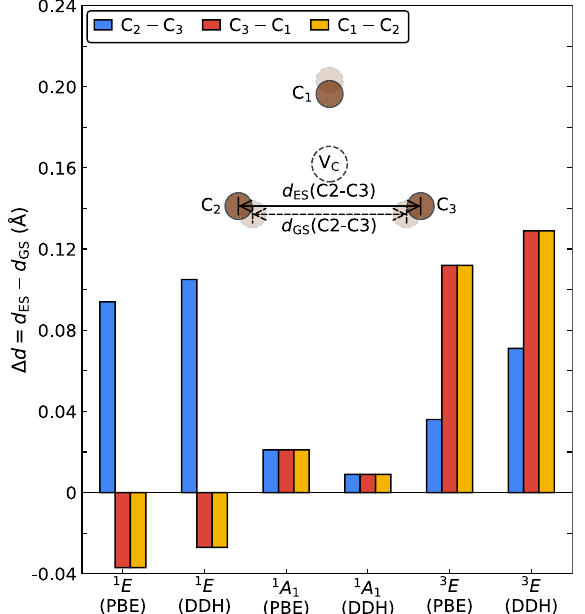
Fig. 3 Geometrical con fi gurations of many-body states of the NV − center in diamond. Differences of the distances between the three carbon atoms (C 1 , C 2 and C 3 ) around the vacancy site (V C ), as obtained in the excited states (ES) and ground state (GS): − d Δ d = d 1 E , 1 A 3 E ES GS . The differences are reported for the 1 and ESs and are computed using TDDFT with PBE or DDH functionals. Note that Δ d (C 1 − C 2 ), Δ d (C 2 − C 3 ) and Δ d (C 3 − C 1 ) for the 3 E state differ, due to the coupling of the electronic state to both a 1 and e type phonon modes (see text). For the 1 A 1 state, Δ d (C 1 − C 2 ), − C Δ d (C − C Å , Δ d (C 2 3 ) and 3 1 ) are instead all equal to ~0.02 implying that in this case the equilibrium geometry preserves the C 3v symmetry and is close to that of the 3 A 2 ground state. The differences Δ d (C 1 − C 2 ), Δ d (C 2 − C 3 ) and Δ d (C 3 − C 1 ) of the 1 E state differ, due to a signi fi cant coupling with e type phonon modes, leading to symmetry